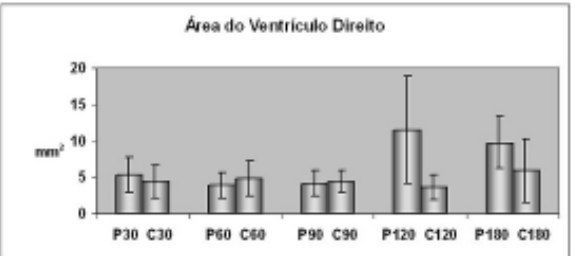
Fig. 8 – Área média da cavidade ventricular direita (em mm 2 ), nos grupos papaína e controle, nos diferentes períodos